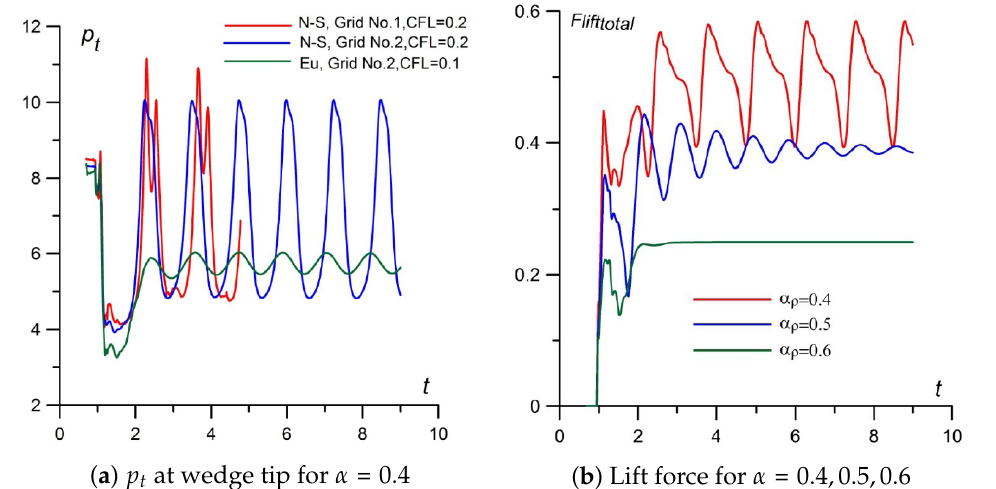
Figure 45. Stagnation pressure at wedge tip and lift force versus time. Adapted from